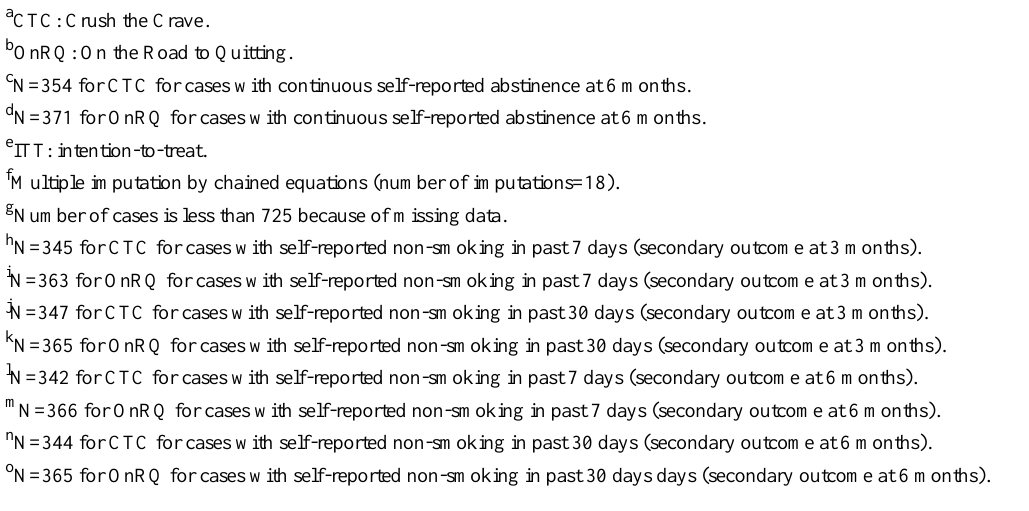
Table 2. Comparison of Crush the Crave and On the Road to Quitting on primary and secondary outcomes at 3 and 6 months (intention-to-treat). Continuous self-reported abstinence at 6 months, n